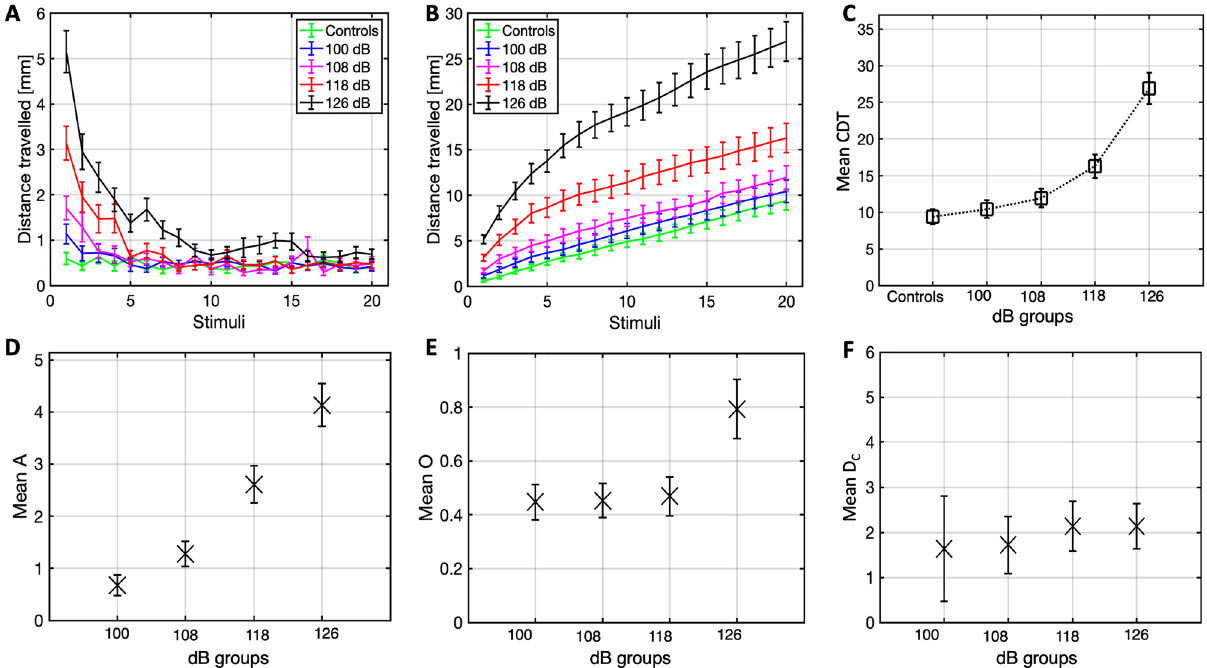
Figure 4. Plots of the distance travelled (M ± 1 SE) at each stimulus ( A ), cumulative distance travelled over successive stimuli ( B ), and mean CDT boxplots ( C ) for all the acoustic power groups and the control group. Boxplots for the amplitude ( D ), offset ( E ) and decay constant ( F ) of 250 bootstraps (M and SE), for all acoustic power conditions.